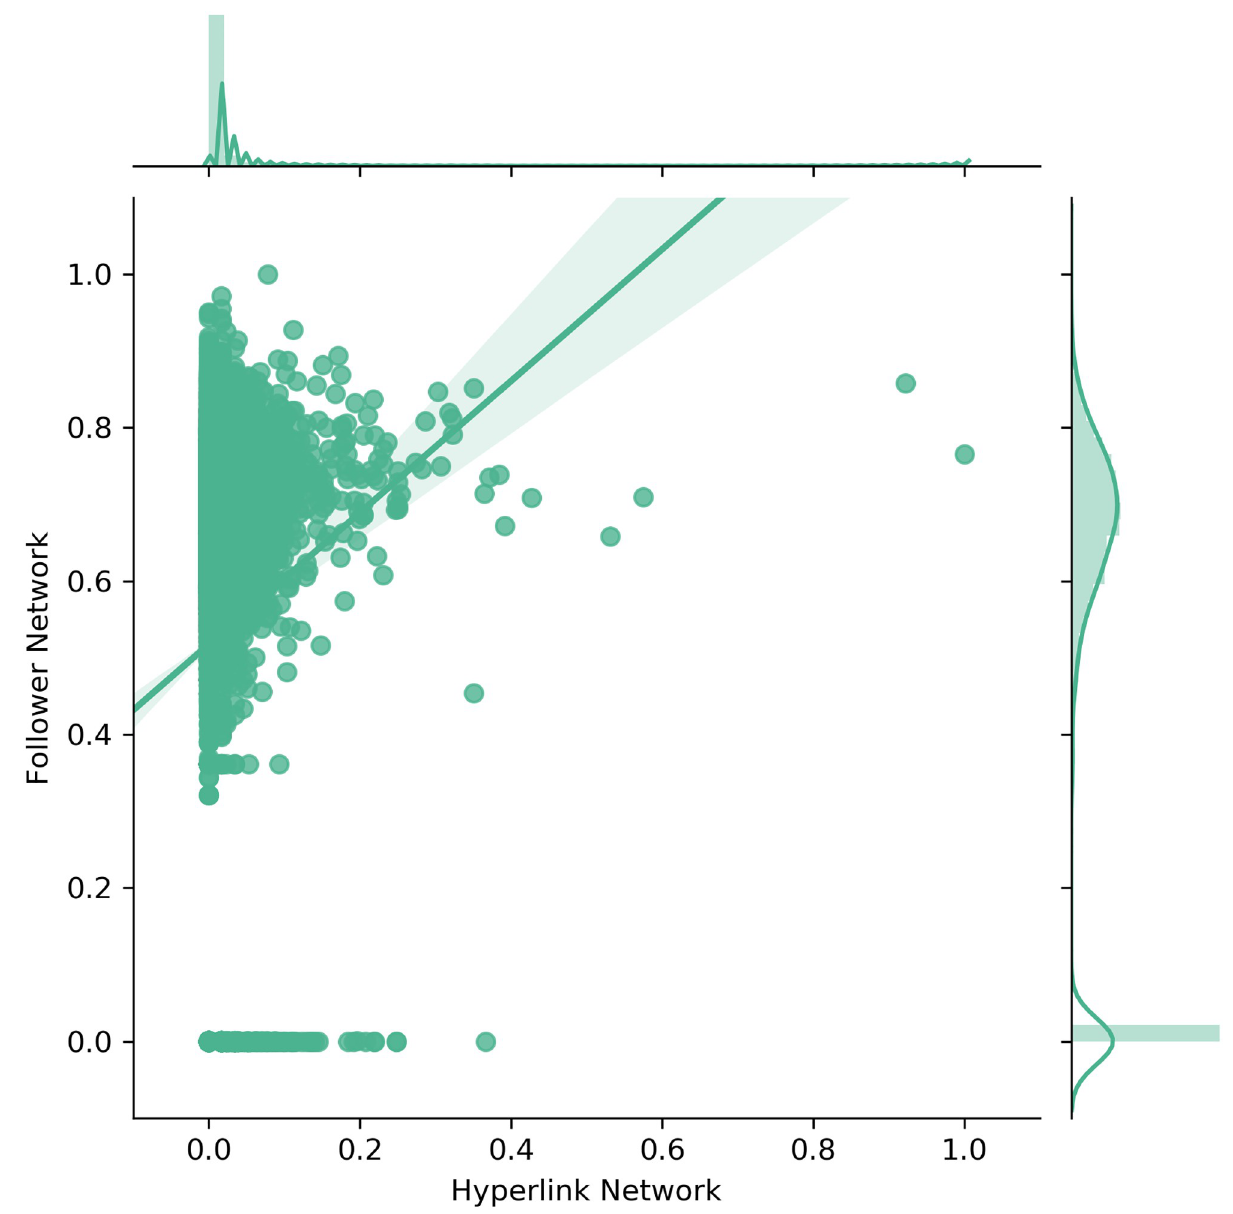
Fig 5. Scatter and density plots for closeness